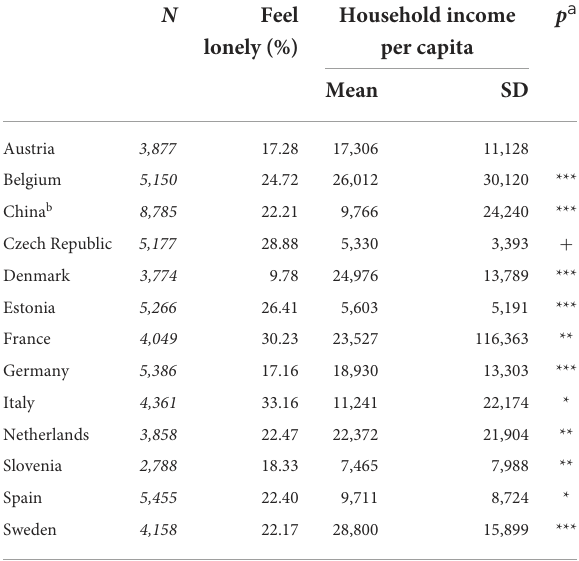
TABLE 2 Descriptive statistics for the sample of older adults (50 + ) by